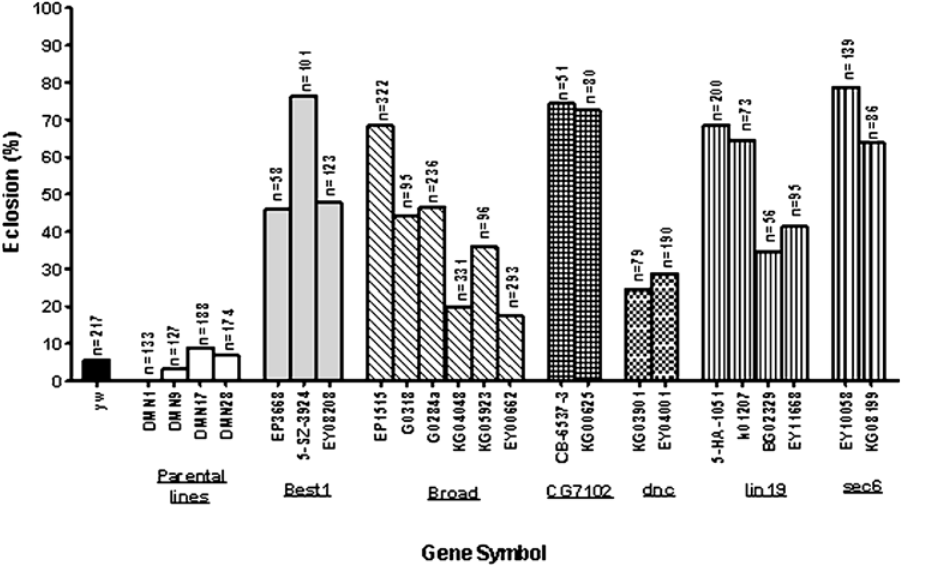
Figure 4. Survival of P-element insertion alleles of candidate genes in severe O 2 environment. Survival of single P -element insertion lines for specific candidate genes. Embryos from each P -element insertion line were collected and cultured at 5% O 2 condition. Total and eclosed pupae were counted and the ratio of eclosion for each allele was compared to that of yw and NF controls. Each bar represents the average of at least three tests of individual P -element insertion lines. The total number of scored pupae was indicated over each bar. The statistical significance was obtained when p values were , 0.001 (Chi-squared test).